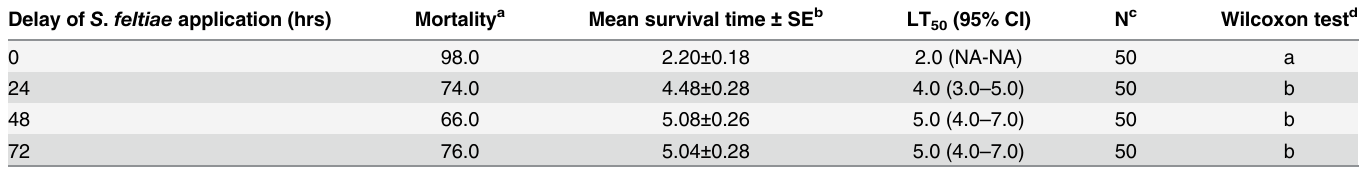
Table 5. Corrected mortality (%), mean survival time and LT 50 (days) of L . decemlineata last-instar larvae treated by I . fumosorosea CCM 8367 in combination with S . feltia e. Delay of S . feltiae application (hrs)